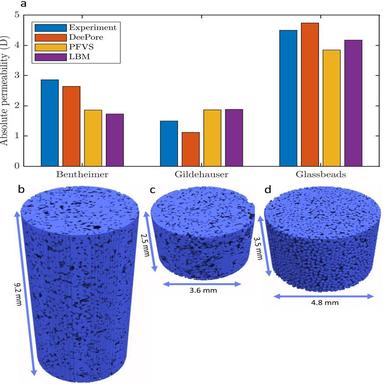
Experimental verification of the proposed model by comparing absolute permeabilities with experimental values as well as direct numerical simulation, (a) Absolute permeabilities of Bentheimer sandstone, Glidehauser sandstone, and glass beads obtained from 4 different sources: experiment, DeePore, PFVS, and LBM. (b) Segmented image of the tested Bentheimer sandstone with resolution of 7 μm/voxel. (c) Segmented image of the tested Glidehauser sandstone with resolution of 4.4 μm/voxel. (d) Segmented image of